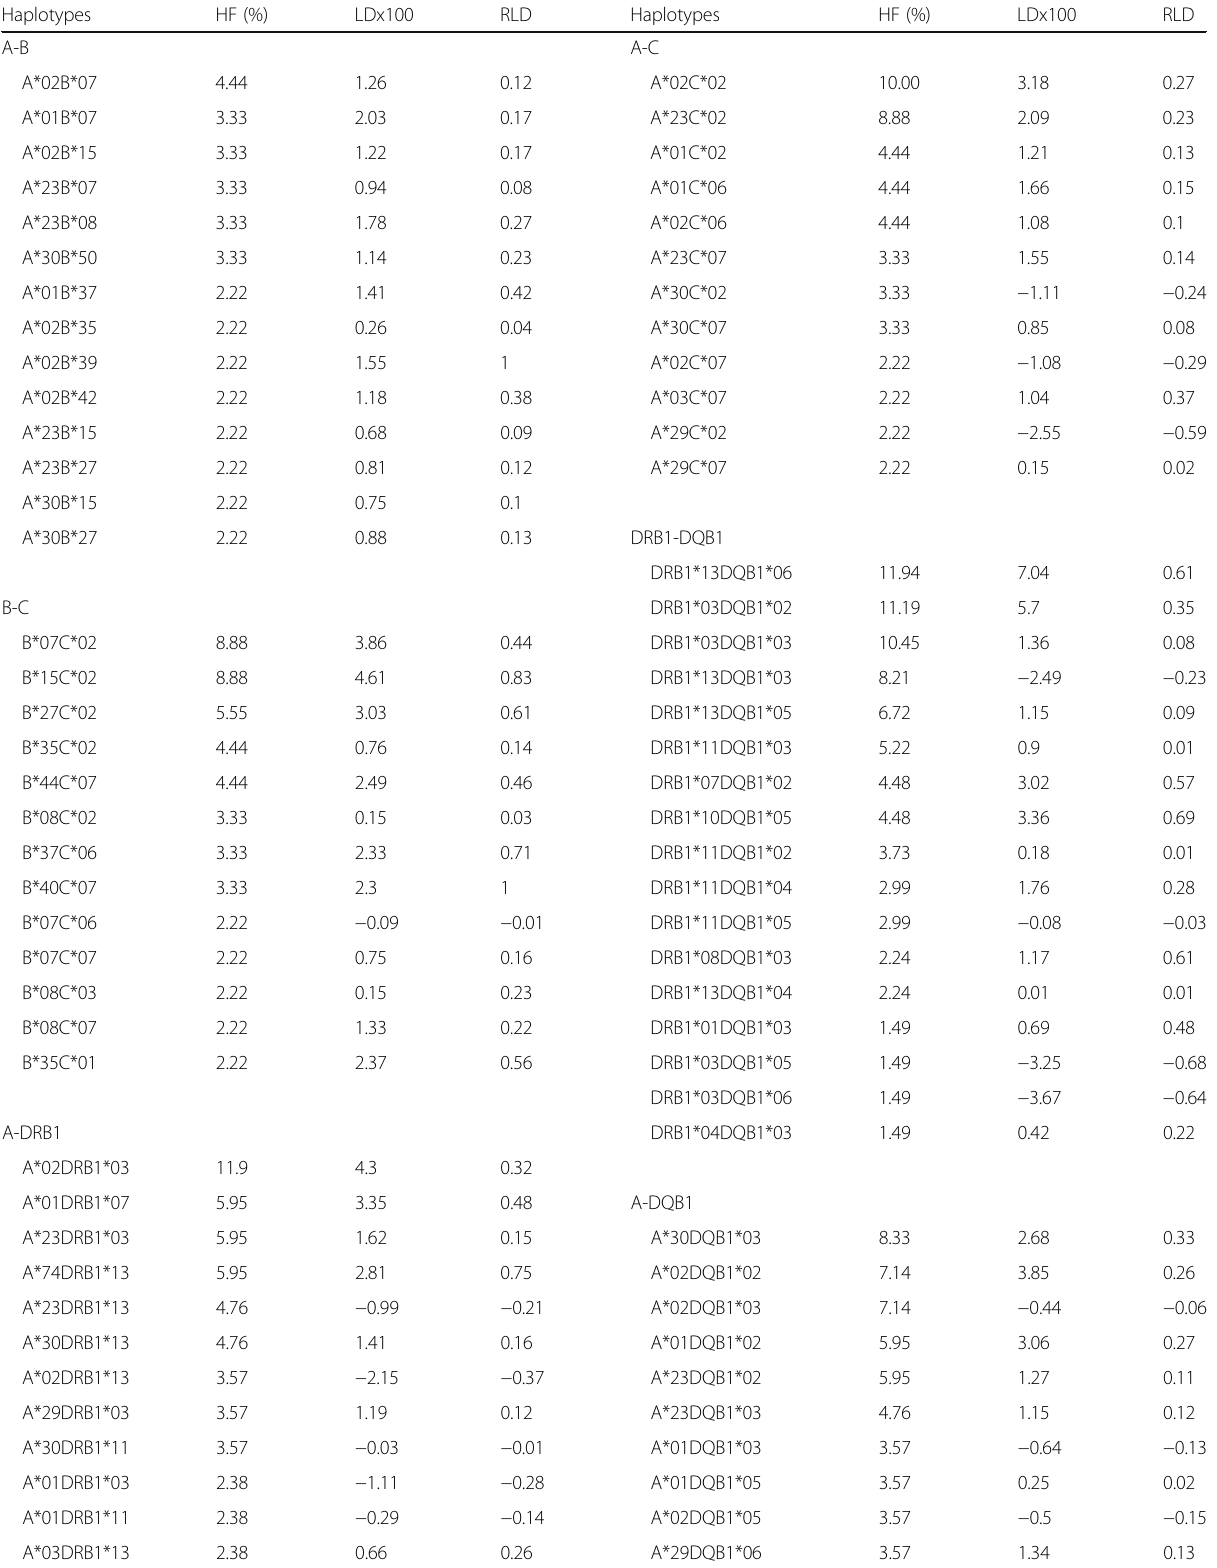
Table 4 Most encountered HLA (class I-class II) two loci haplotypes